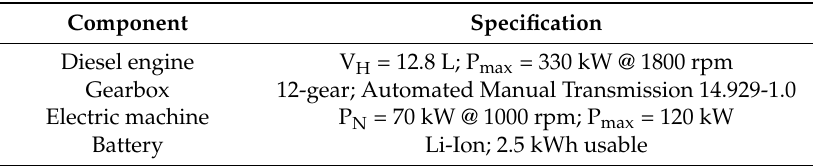
Table 1. Technical specifications powertrain